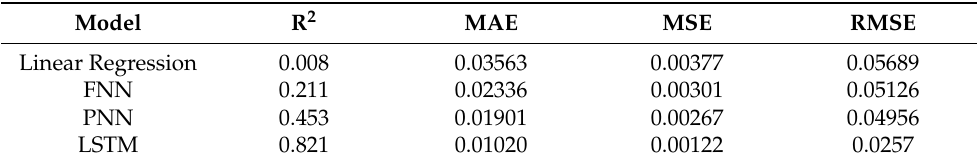
Table 6. Results of the statistical checks of the models with Current (CT), CO 2 , Relative Humidity (RH) and Air Velocity (V) as inputs. Model R 2 MAE Linear